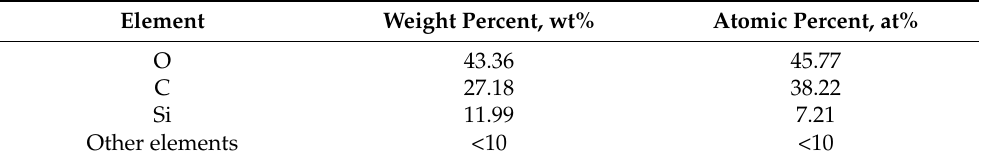
Figure 5. EDS analysis result for fly ash.